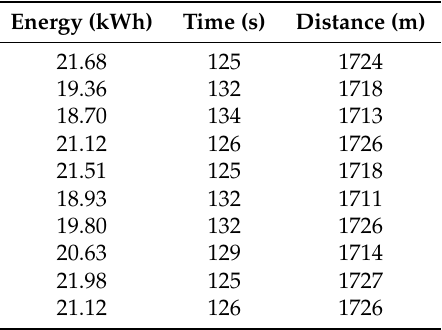
Table 2. OSP energies, times and